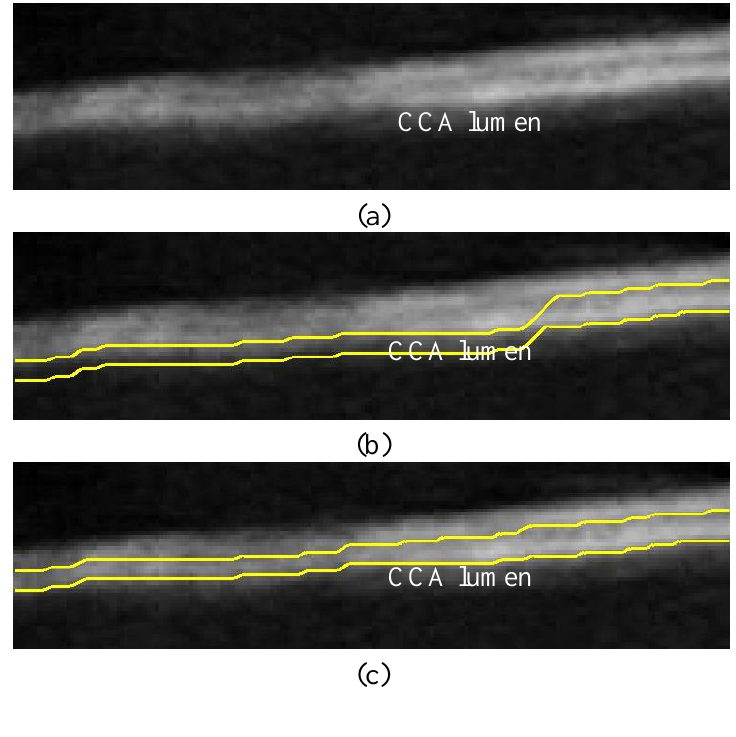
Figure 10. (a) Sub-image. (b) Result made by [7]. (c) Result of the proposed method. (Sequence